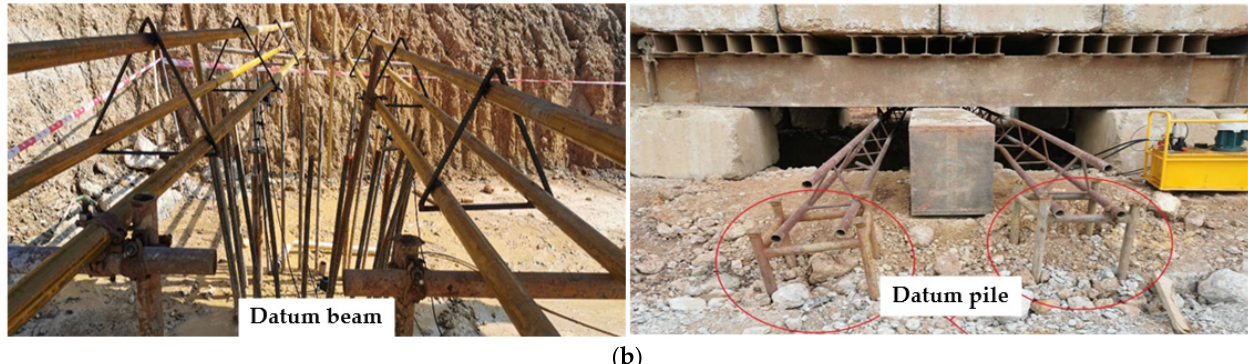
Figure 4. Construction of ballast platform: ( a ) schematic diagram of surcharge test device and ( b ) datum beam and datum pile.